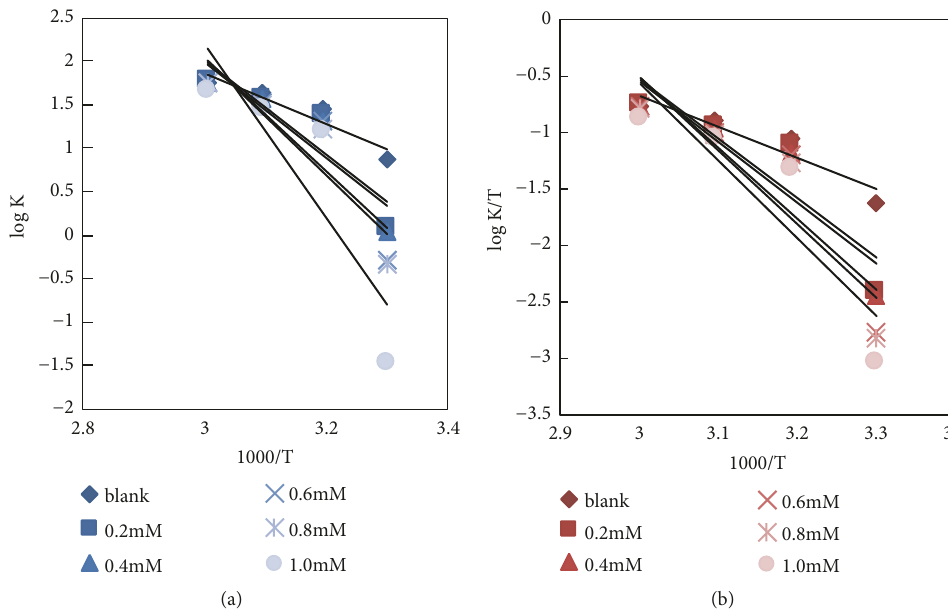
Figure 6: Plot of (a) log K versus 1000/T (b) log K / T versus 1000/T with and without DmChDp in 1M HCl.